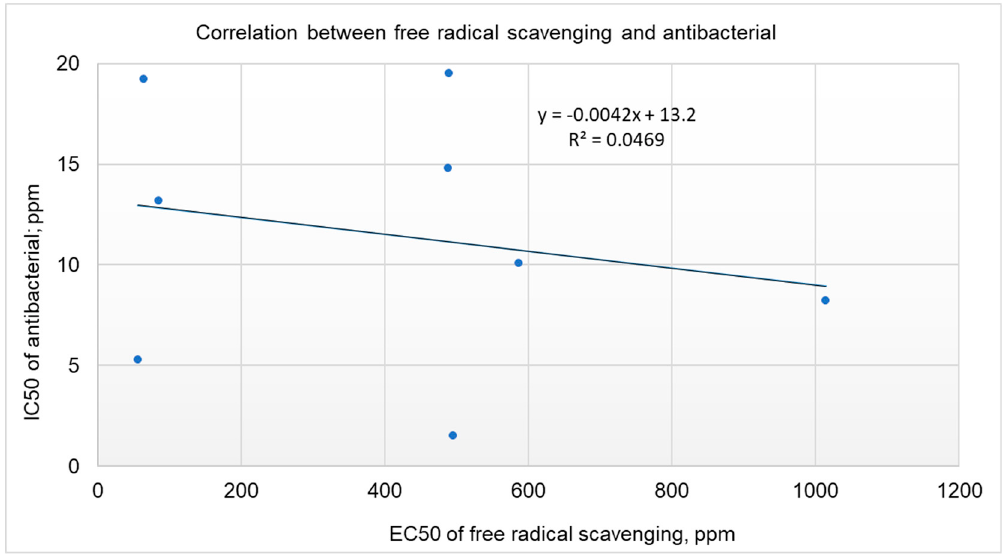
Figure 2. Correlations between antibacterial activity (IC 50 ) and the EC 50 for free radical scavenging for the eight most active plant extracts against S. mutans .